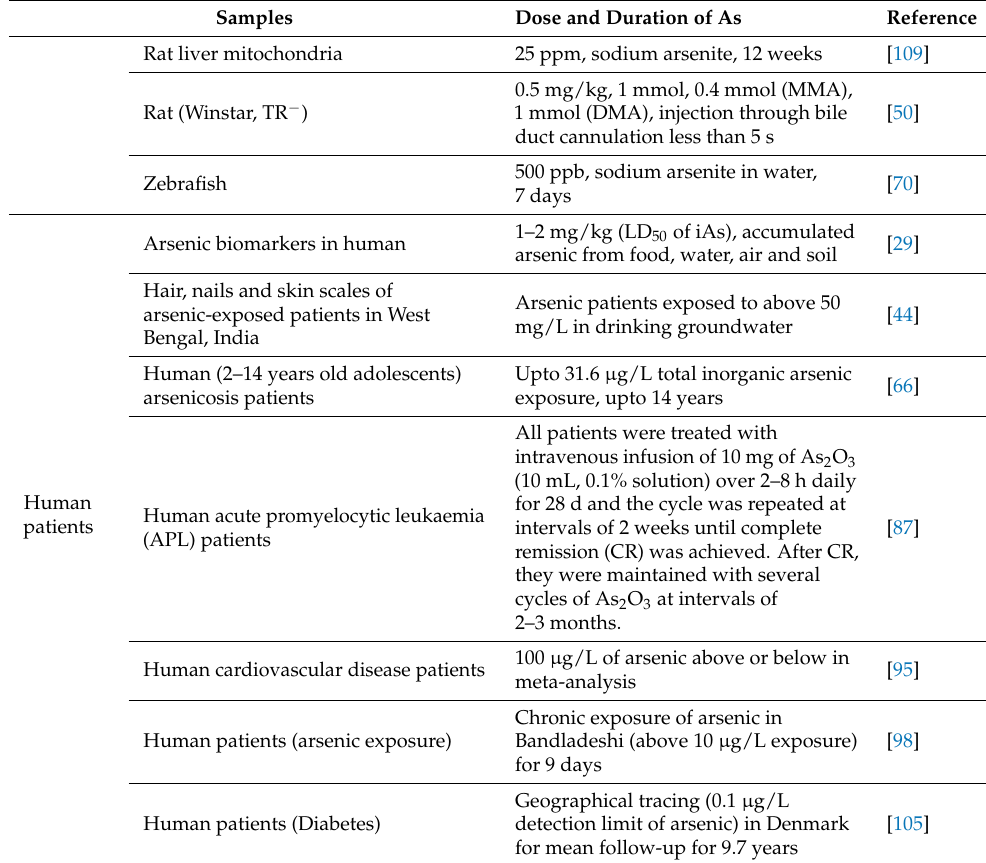
Table 1. Cont. Samples Dose and Duration of